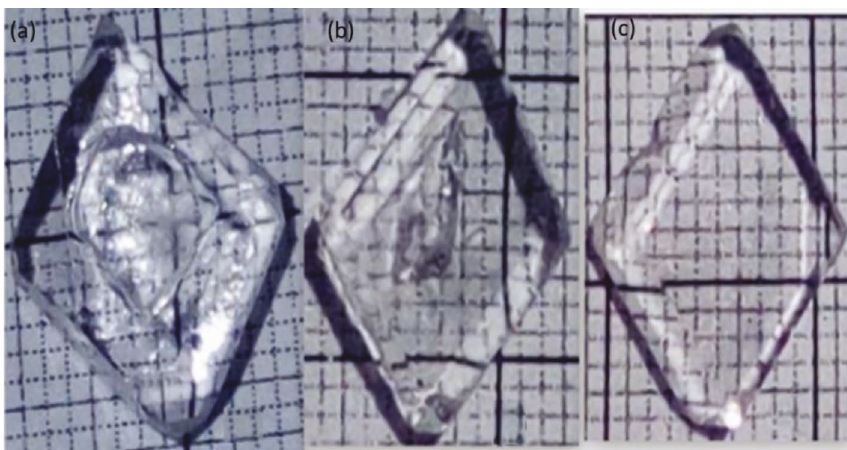
Figure 1: Photographic images of (a) undoped, (b) 1 mol% MgCl